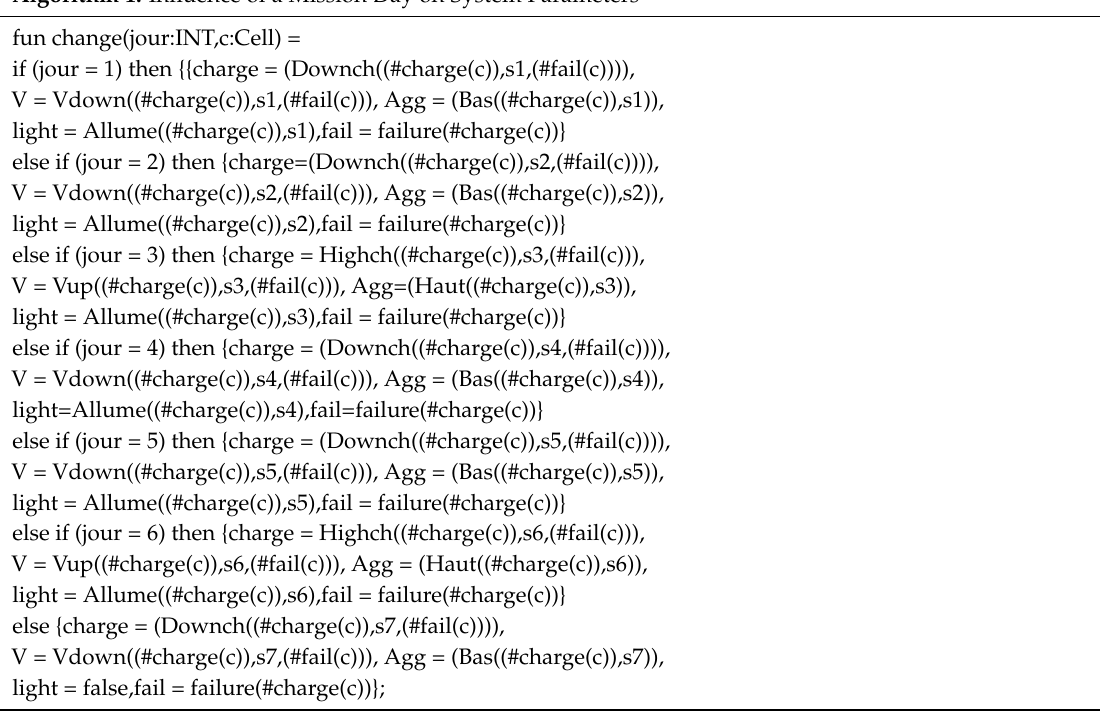
Algorithm 1: Influence of a Mission Day on System